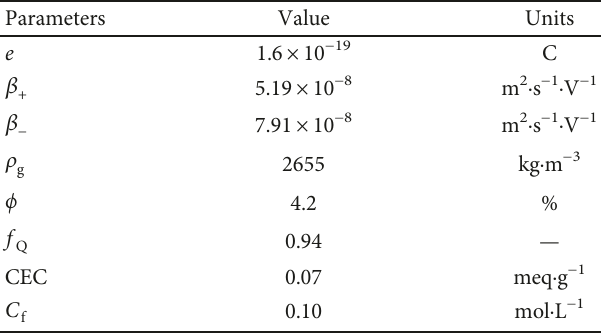
Table 1: Analysis parameters of membrane e ffi ciency. Parameters